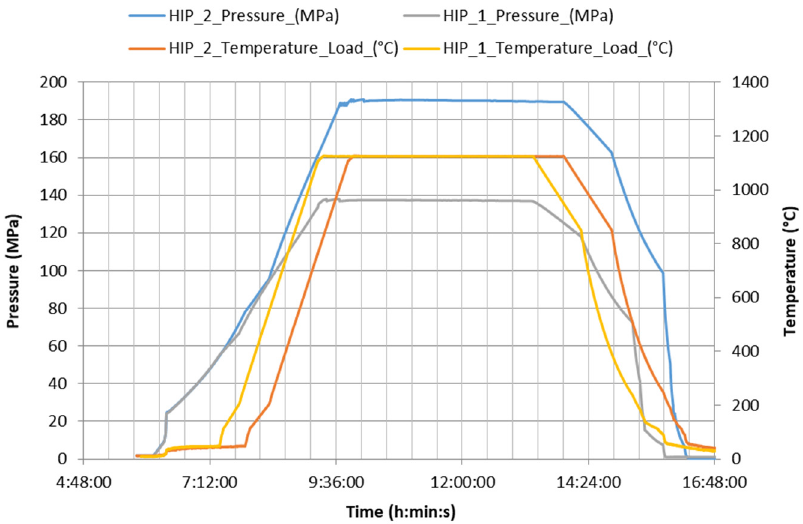
Figure 3. Temperature and pressure during hot isostatic pressing (HIP) processes.